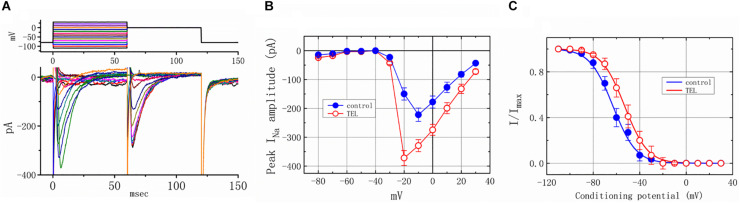
Voltage dependence of the stimulatory effect of TEL on INa in mHippoE-14 neurons. Cells were bathed in Ca2+-free Tyrode’s solution containing 10 μM TEA. (A) Superimposed voltage and current tracings in the presence of 3 μM TEL. The voltage profile tested is shown in the upper part of (A). (B)
I–V relationships of peak INa in the absence (⚫) and presence (◯) of 3 μM TEL (mean ± SEM; n = 8–9 for each point). (C) Steady-state inactivation curve of INa in the absence (⚫) and presence (○) of 3 μM TEL (mean ± SEM; n = 8–9 for each point). The steady-state inactivation parameters with and without the addition of Tel (3 μM) were obtained. The normalized amplitude of INa (I/Imax) was constructed against the conditioning potential, and the smooth curves were well fit with the Boltzmann equation (Equation 4).